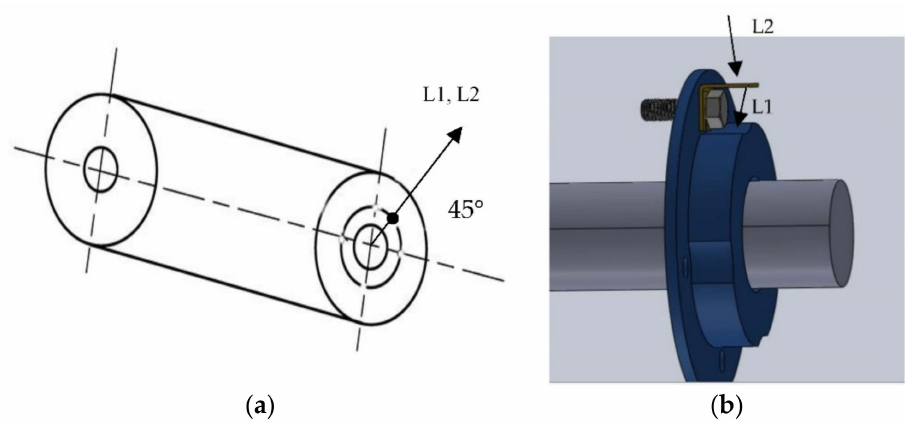
Figure 2. Sensor mounting position: L1 when the accelerometer is placed directly on a bearing seat; and L2 when the accelerometer is placed on a manufactured bracket: ( a ) The angle of the accelerometer mounted, and ( b ) The position of the accelerometer